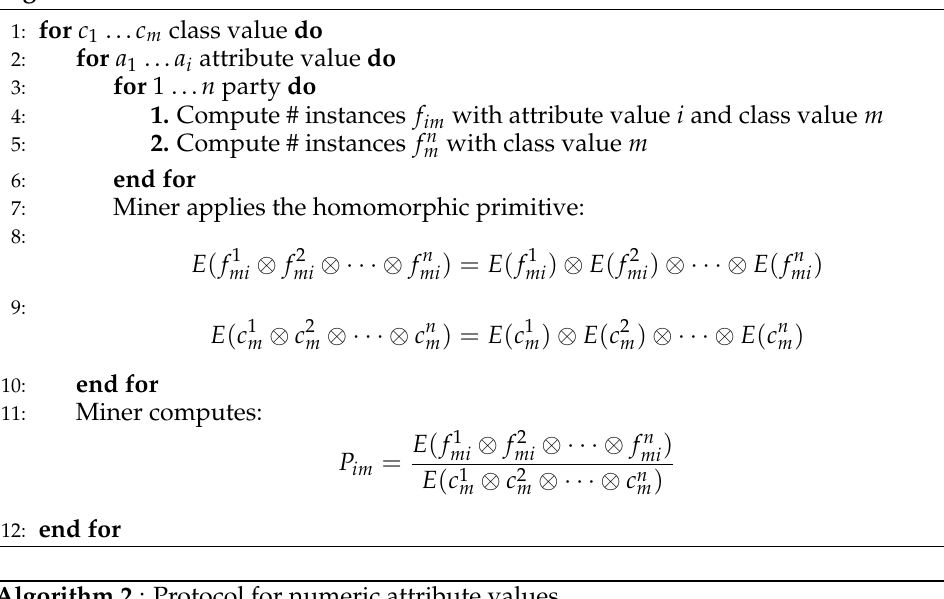
Algorithm 1 : Protocol for nominal attribute values.